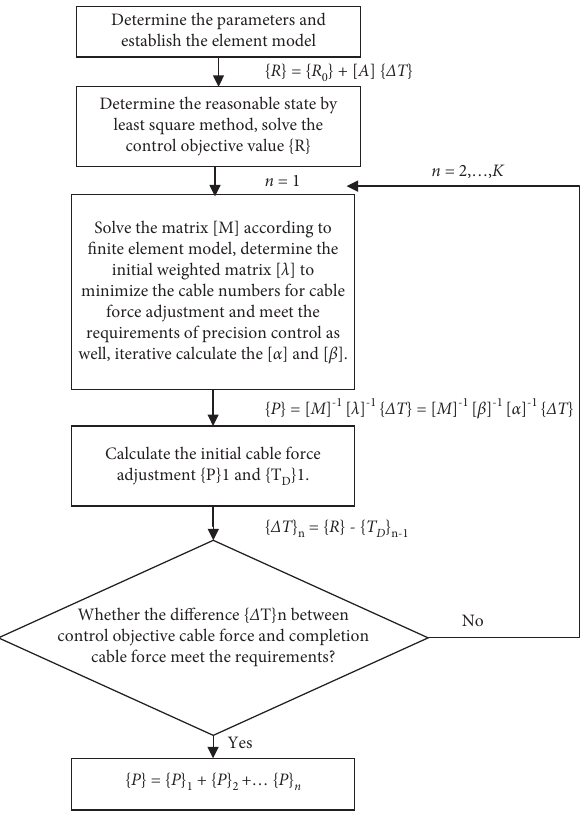
Figure 1: Flowchart of the cable force adjustment.